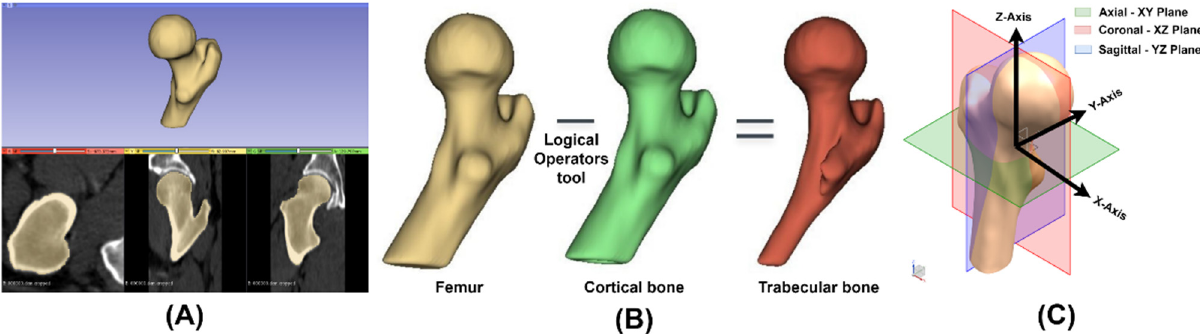
Figure 1. ( A ) Segmentation of the right femur using 3D Slicer ® . ( B ) Process to obtain the trabecular bone. ( C ) Femoral coordinate system.